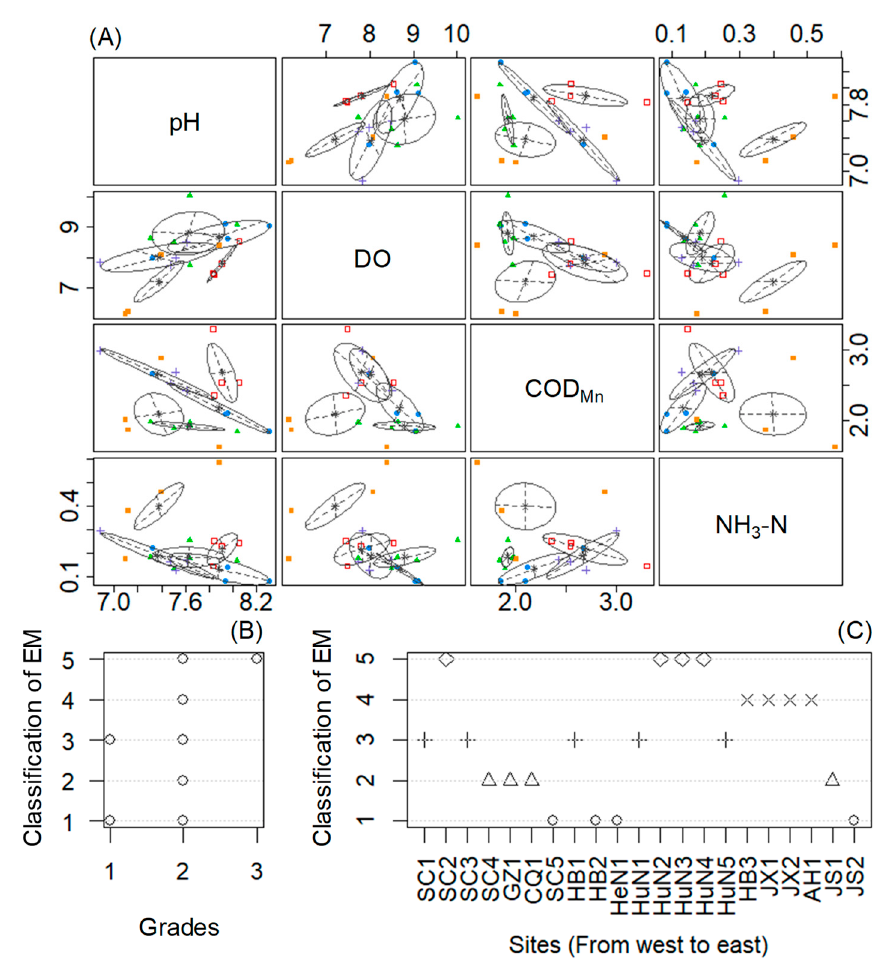
Figure 5. Classification of the 21 YRB sites in 2016 by EM clustering based on the yearly means of the four monitoring indicators: Data distribution ( A ), grades ( B ), and geographical distribution ( C ). Note: Diamonds, x crosses, crosses, triangles and circles in ( C ) indicate different EM clusters.